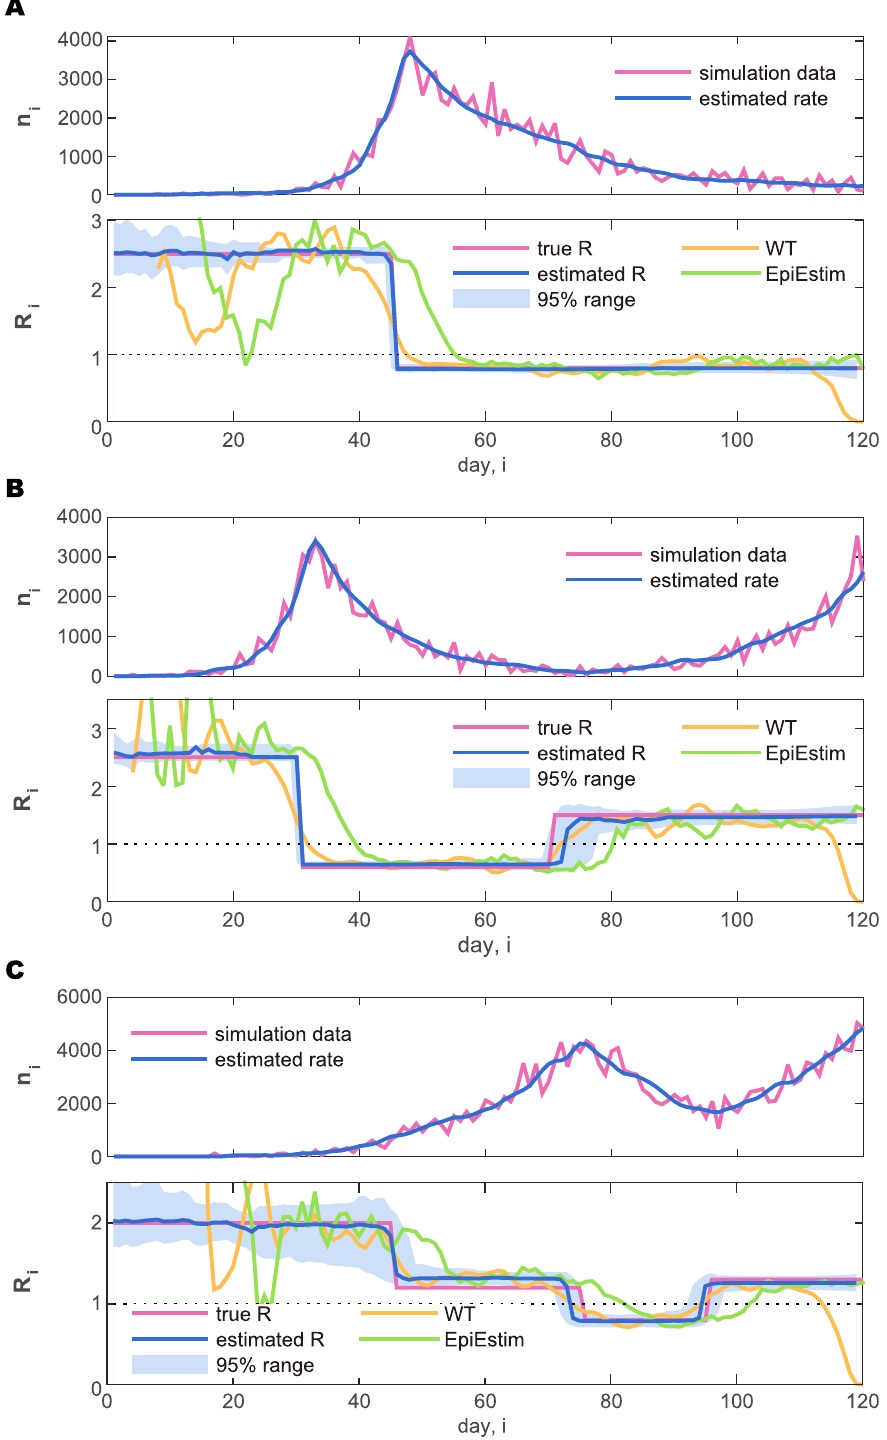
Fig 3. Synthetic daily cases generated by simulating the Hawkes-type count process and the estimated reproduction number. (A) Rapid increase followed by a slow decrease. (B) Increase followed by a rapid decrease, and then an increase. (C) Slow increase followed by a decrease, and then another large increase. In the upper panel plotting the number of daily cases (purple line), the rate estimated by the state-space method ^ l is also plotted (blue line). In the i lower panel, the reproduction number ^ R estimated with the state-space method is plotted in reference to the true i